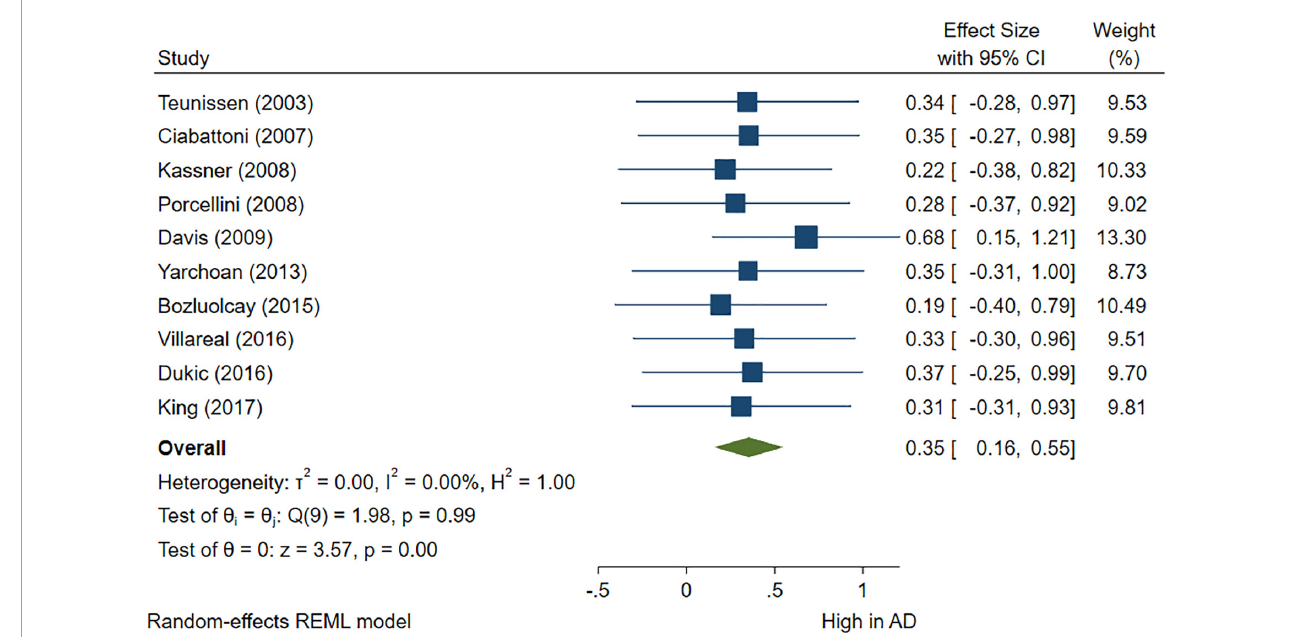
FIGURE2 Forest plot of pooled Hedge’s g depicting high C-reactive protein (CRP) concentration in Alzheimer’s disease (AD) samples compared to controls.